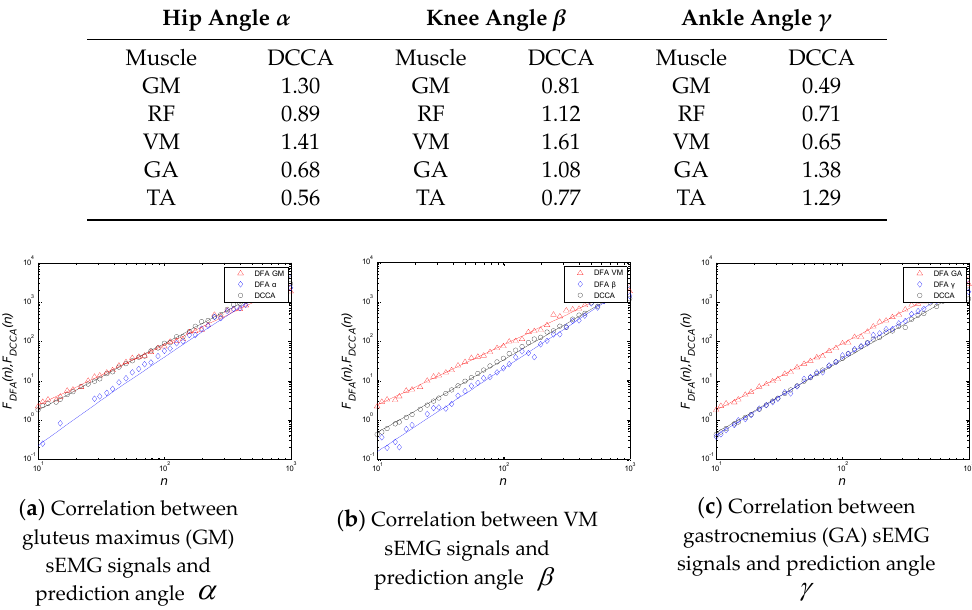
Detrended cross-correlation analysis (DCCA) index between predictive angles and sEMG signals. Table 5. Detrended cross ‐ correlation analysis (DCCA) index between predictive angles and sEMG signals.